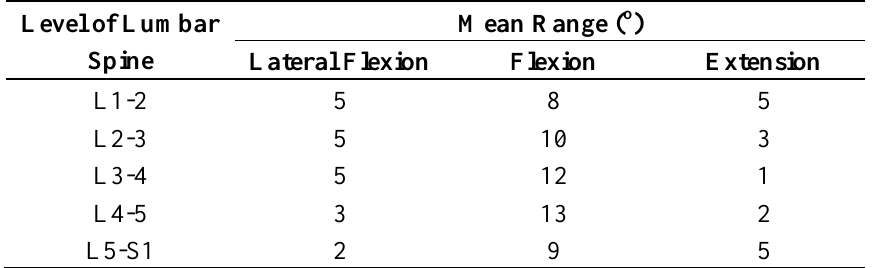
Table 3. Ranges of segmental motion for different motion types